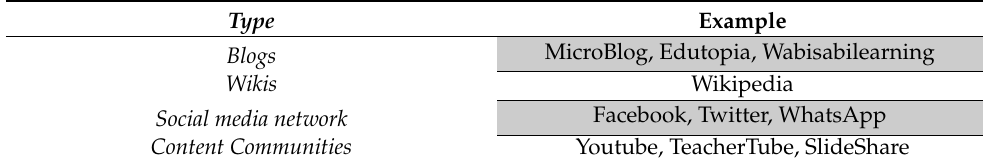
Table 2. Social Media Types.